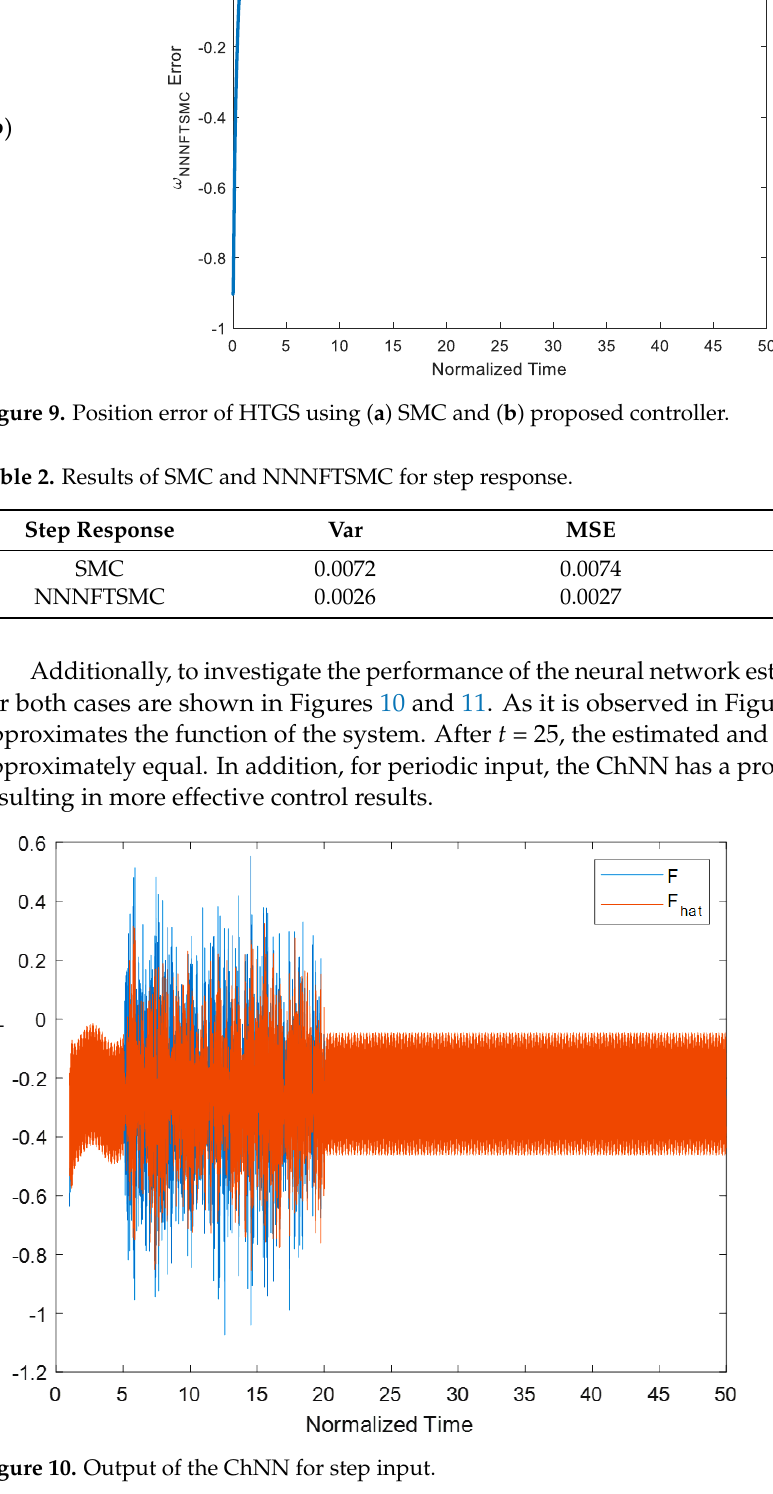
Figure 11. Output of the neural network for periodic input.